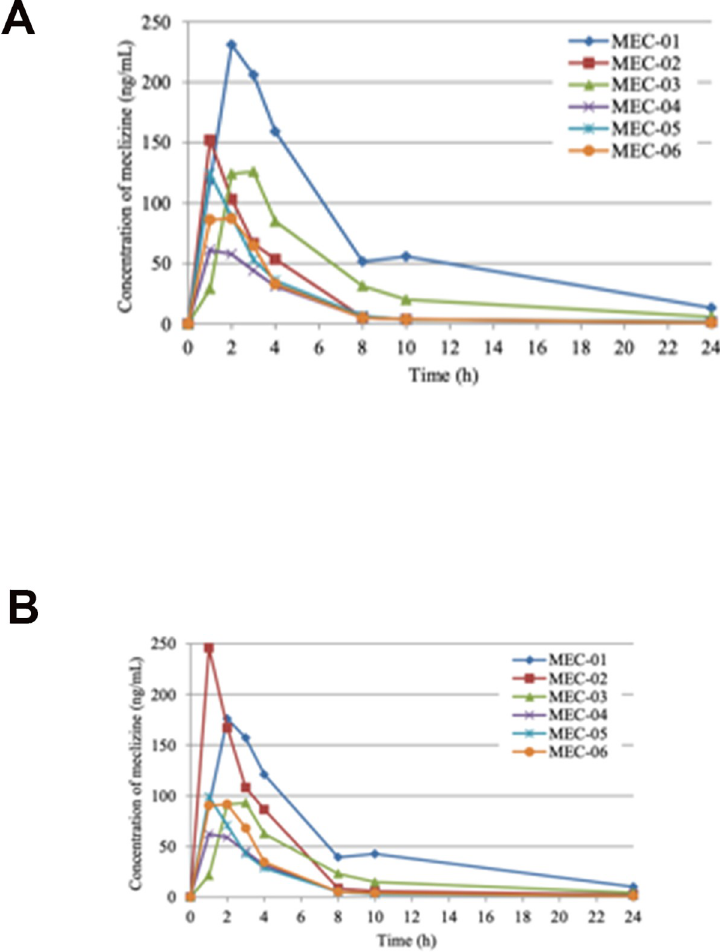
Fig 2. Plasma concentration of meclizine from pre-dosing to 24 hours after single oral administration of meclizine hydrochloride 25 mg tablet. Individual plasma concentration profiles of meclizine in ACH children (A) and body weight normalized profiles by the mean body weight of MEC-01 to MEC-06 (22.9 kg) (B).